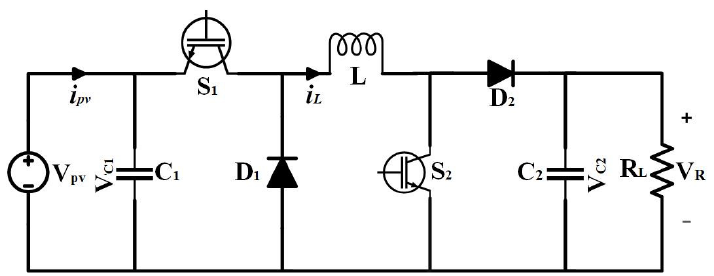
Figure 5. Non-inverted buck boost converter